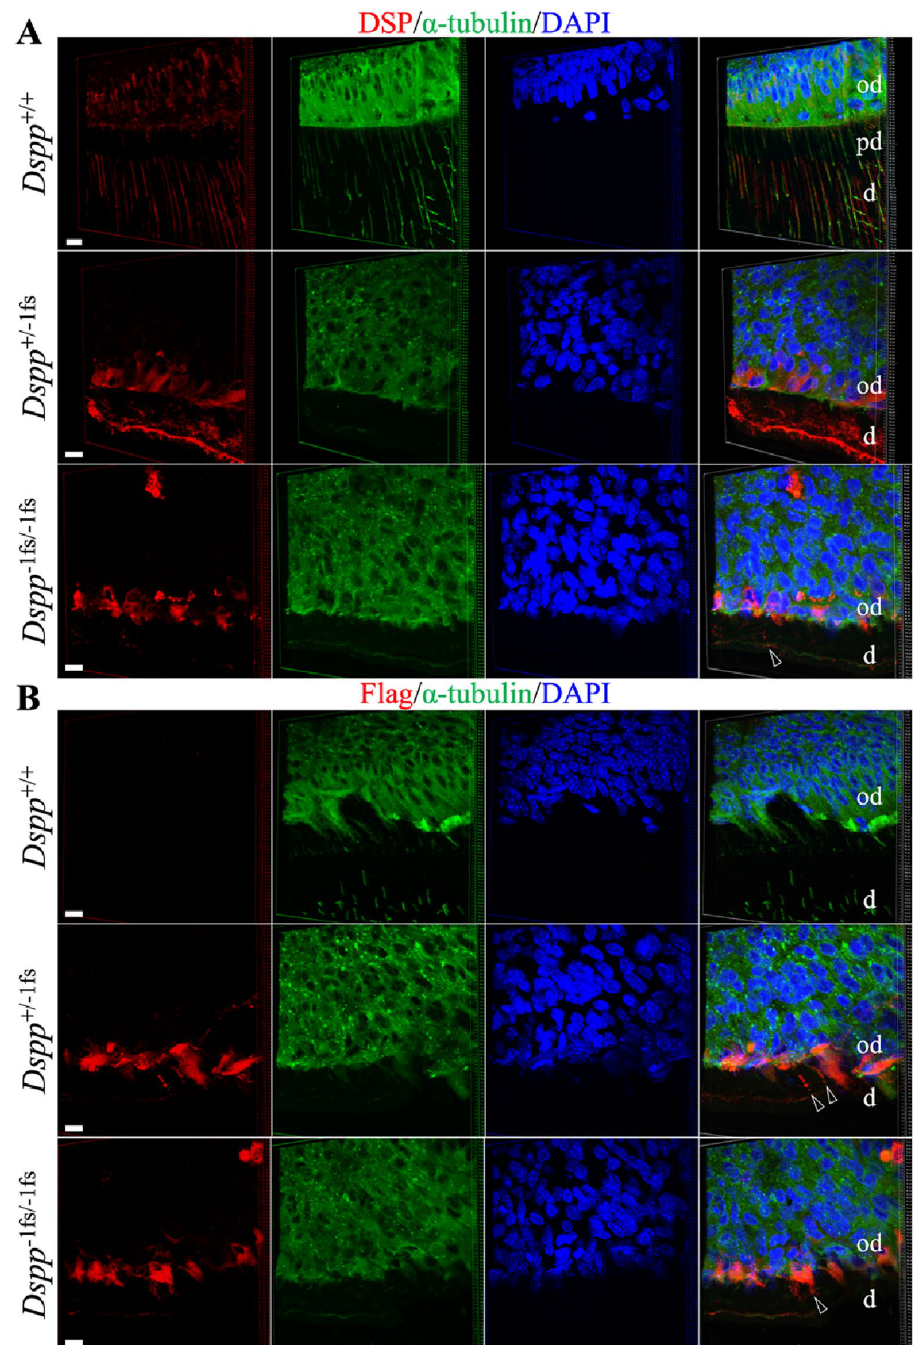
Figure 7. DSPP protein accumulated within the odontoblasts of the Dspp + / −1fs , and Dspp −1fs / −1fs Mice. Immunohistochemistry is performed on the 14-day-old wild-type, Dspp + / −1fs , and Dspp −1fs / −1fs mouse maxillary 1st molars. DSP ( A ) or Flag ( B ), α-tubulin (mapping the boundary of cells), and nucleus (DAPI) are shown in red, green, and blue, respectively. ( A ) Three-dimensional reconstruction of the DSP signal show that mild intracellular DSP signal, and moderate extracellular DSP signals follow the course of the odontoblastic processes in the wild-type mice. The predentin area is weak in DSP signal in the wild-type mice. In Dspp +/−1fs and Dspp −1fs/−1fs mice, elevated intracellular DSP signal is observed, and extracellular DSP scarcely aggregate in the abnormal dentin matrix (arrowhead). ( B ) Three-dimensional reconstruction of Flag signal show strong intracellular accumulation of mutant DSPP and dotted extracellular aggregates of mutant DSPP